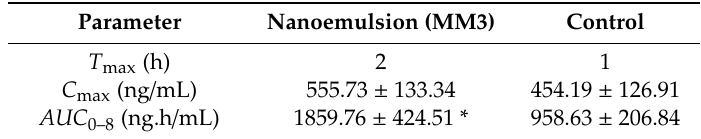
Table 5. Mean pharmacokinetic parameters of moxifloxacin in aqueous humor following topical installation of nanoemulsion (MM3) and control in